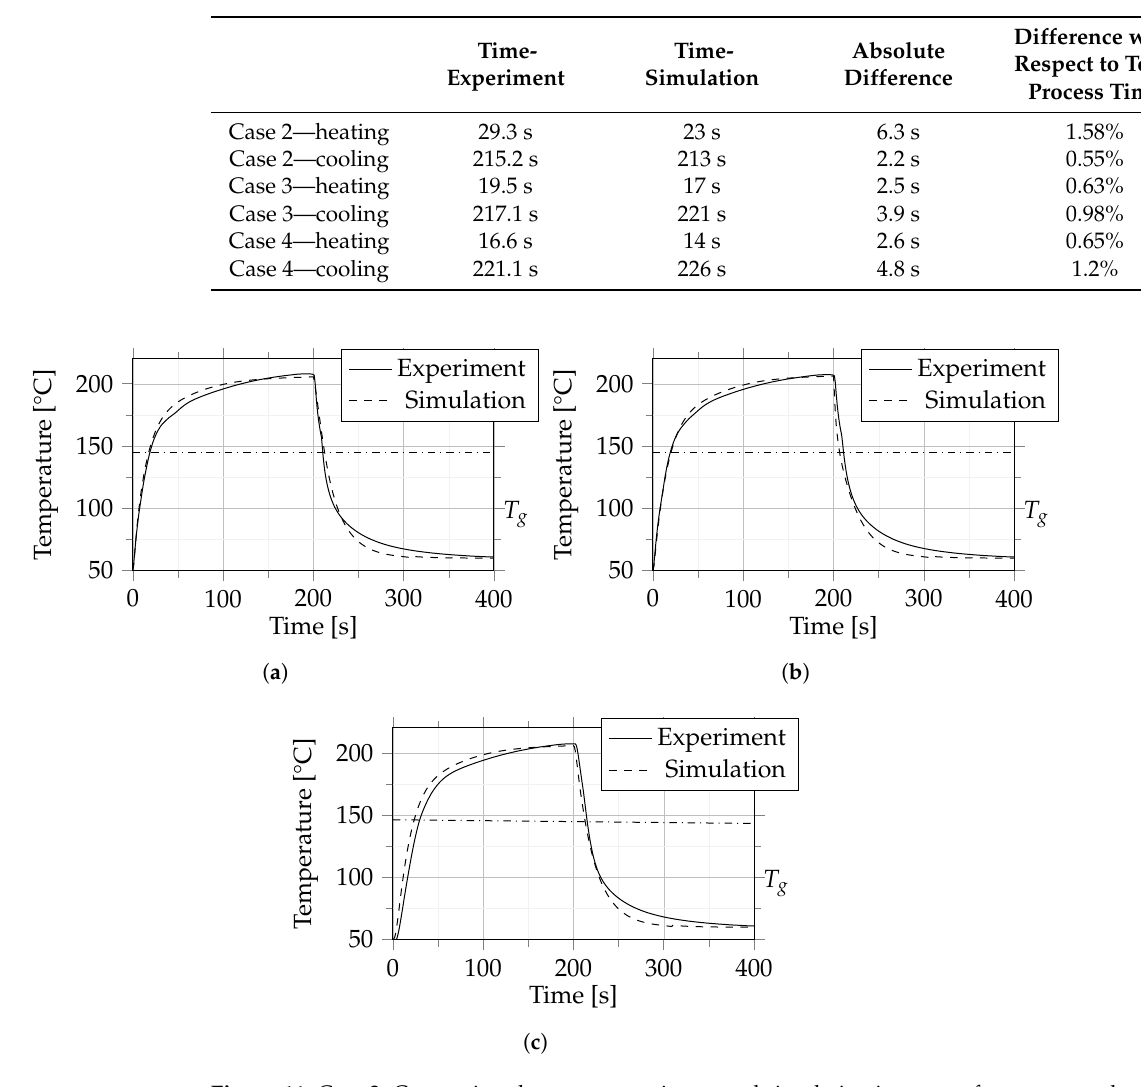
Figure 11. Case 2: Comparison between experiment and simulation in terms of temperature between layers 1 and 2 ( a ), 9 and 10 ( b ) and 17 and 18 ( c ). The dash-dotted line indicates the glass transition temperature ( T g ) of 145